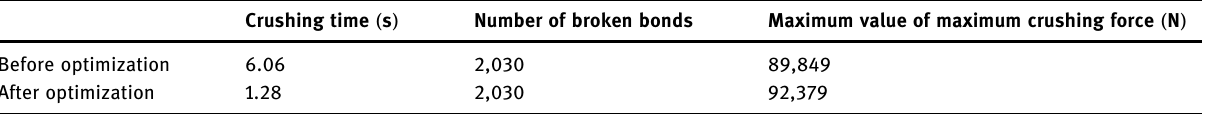
Table 6: Data comparison and